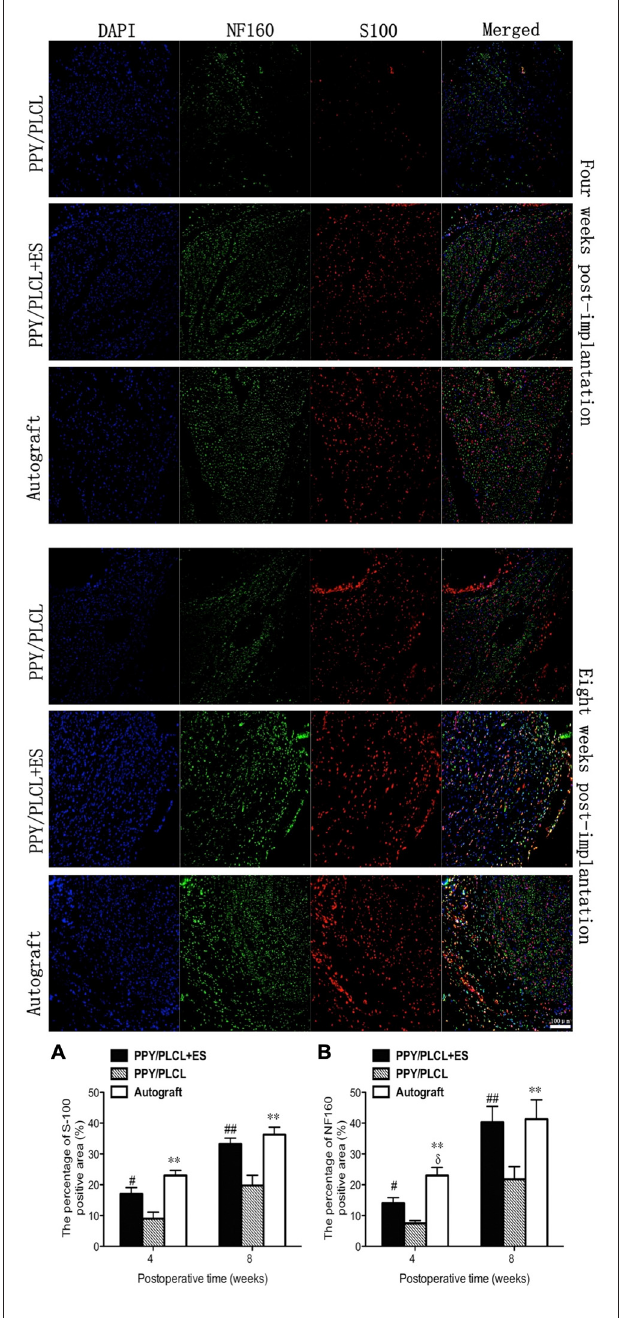
FIGURE 8 | Immunofluorescence analysis of neurofilament 160 (NF160) and S100 in the middle of the sciatic nerve at 4 and 8 weeks post-implantation. The percentages of S100 and NF160 positive area for each group are shown in (A,B) ( n = 5, # p < 0.05, ## p < 0.01 the PPY/PLCL + ES group vs. PPY/PLCL group; ∗ p < 0.05, ∗∗ p < 0.01 the autograft group vs. PPY/PLCL group; δ p < 0.05, the autograft group vs. PPY/PLCL + ES